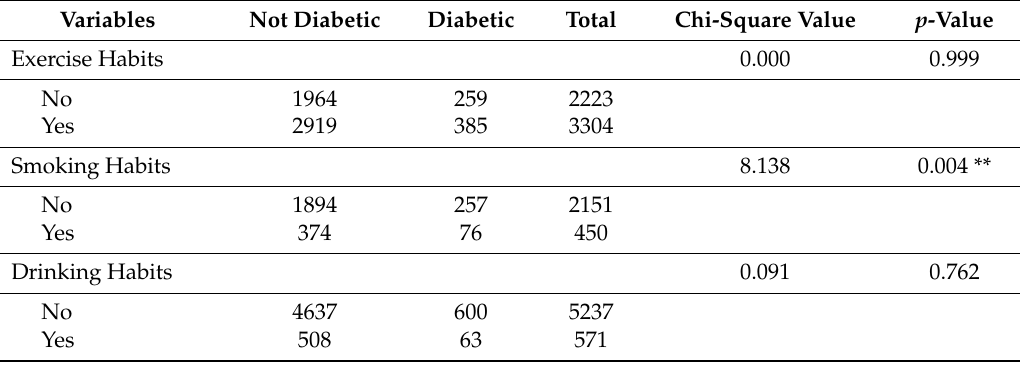
Table 4. Correlation of Each Healthy Behaviors Variable and Having